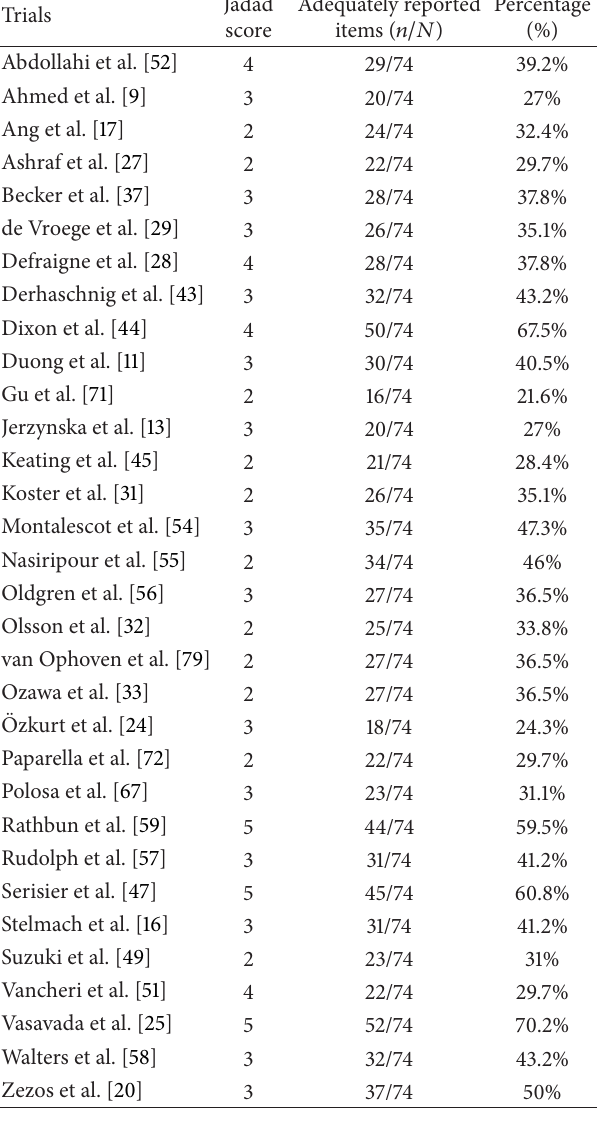
Table 3: Summary of numbers and percentages of adequately reported items in each trial according to CONSORT checklist and Jadad